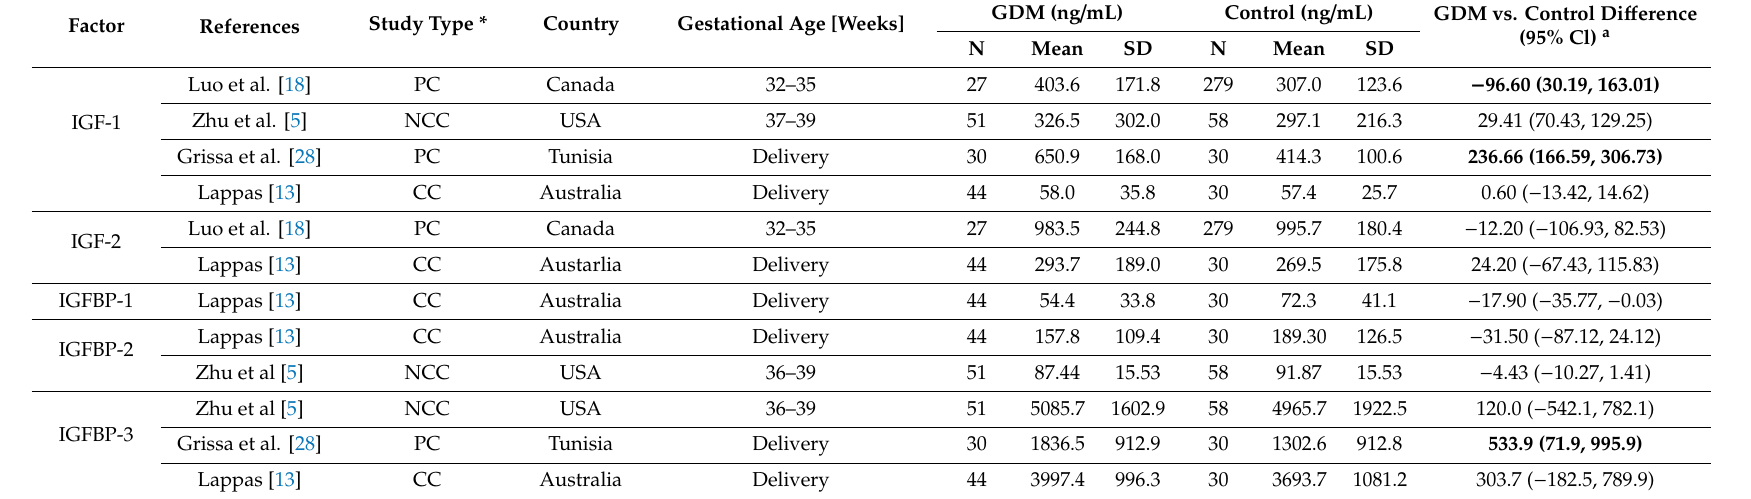
Table 6. Summary data in studies on IGF-1, IGF-2 and IGFBP-1-3 levels in GDM and control (euglycemic)